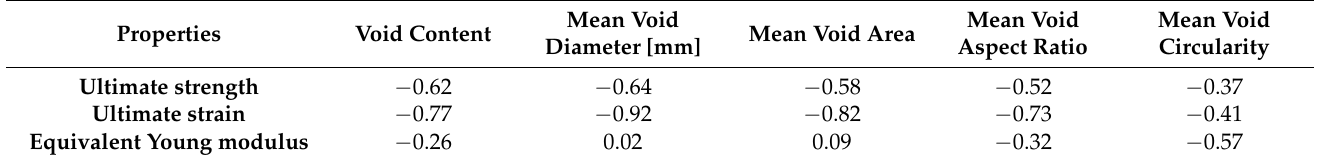
Table 7. Pearson correlations between the mechanical and the topological properties of the